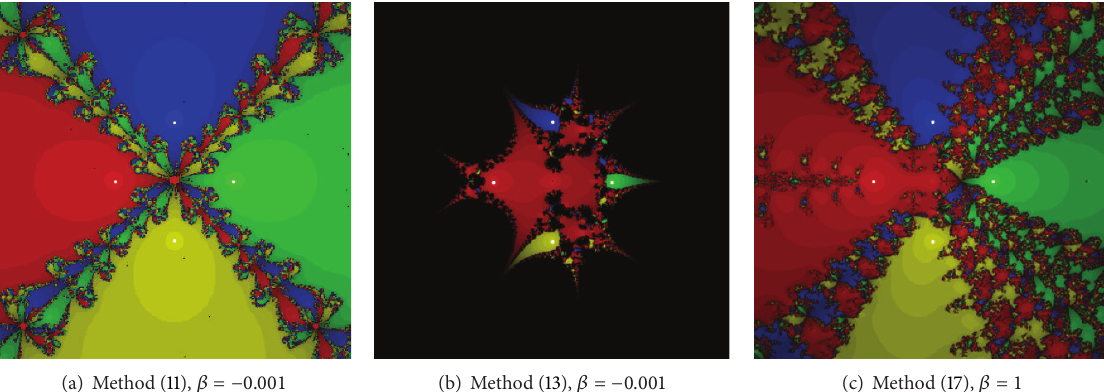
Figure 17: Basins of attraction of (11), (13), and (15) for the test problem 1.